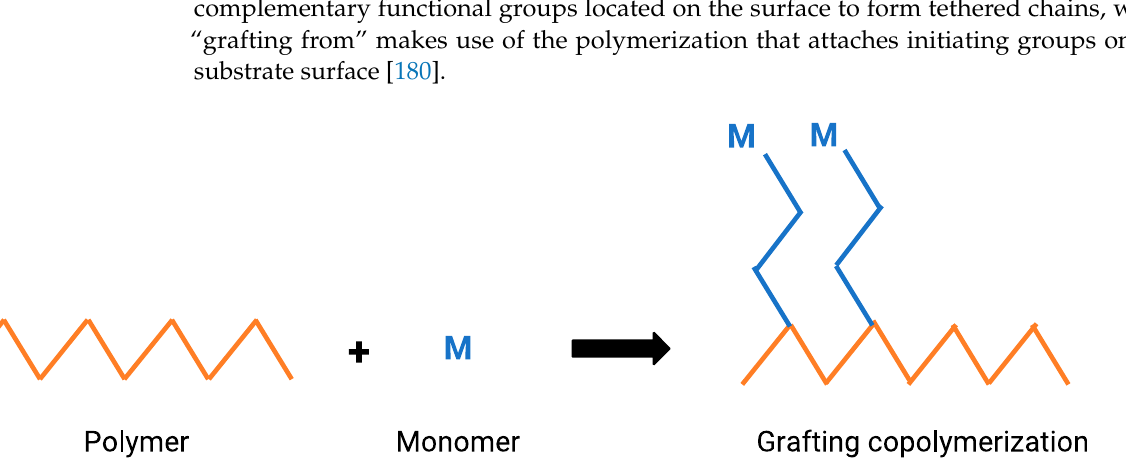
Figure 8. Graft copolymerization process.